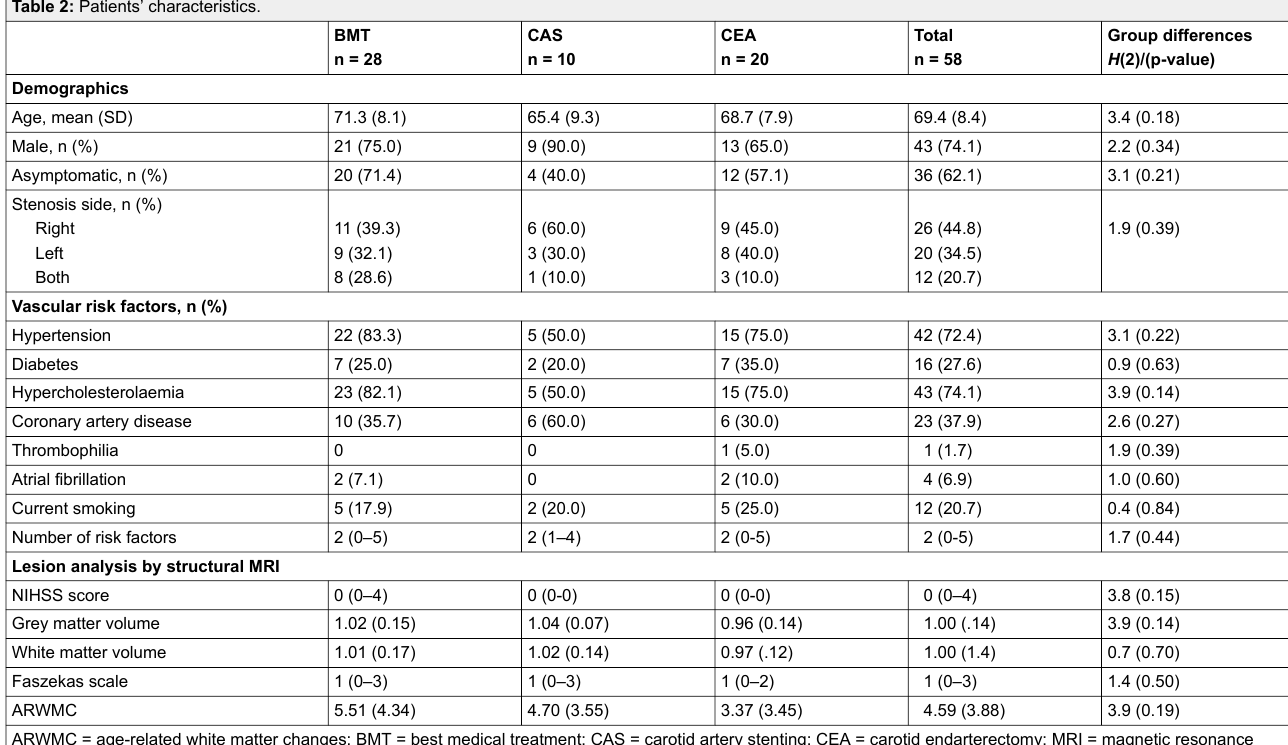
Table 2: Patients’